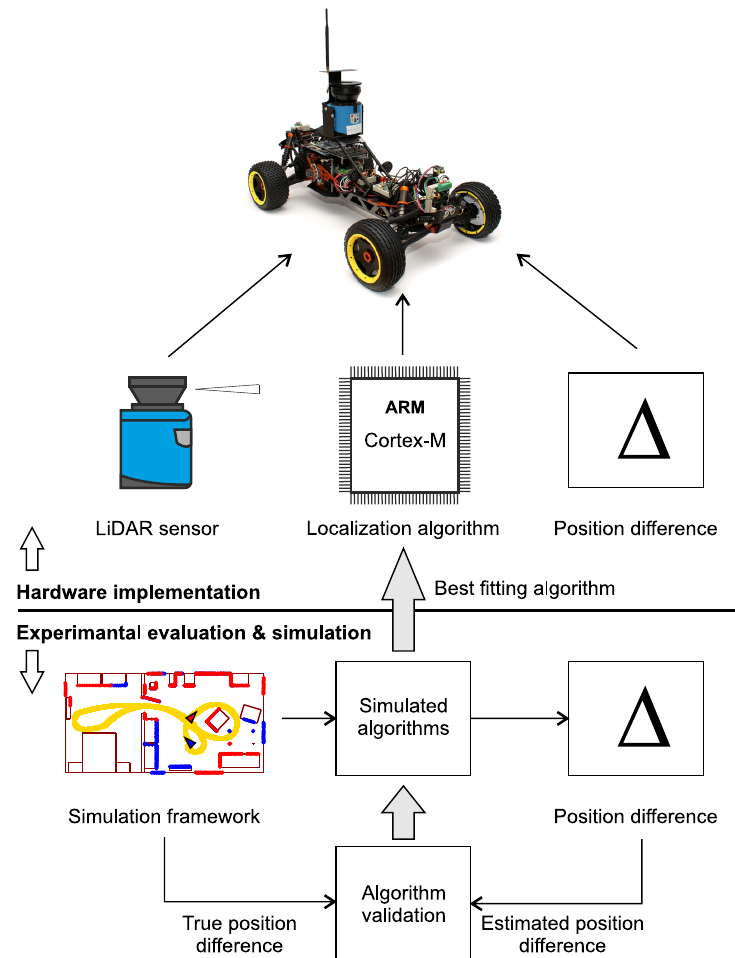
Figure 1. An outline of the simulation-based